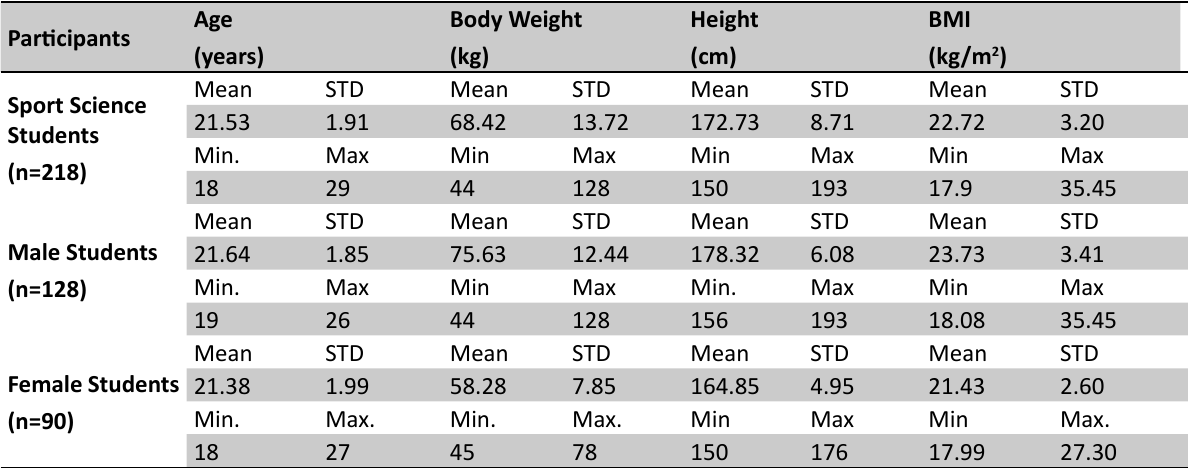
Table 1. Average, standard deviation and range variability values of the body composition of the sport science students Participants